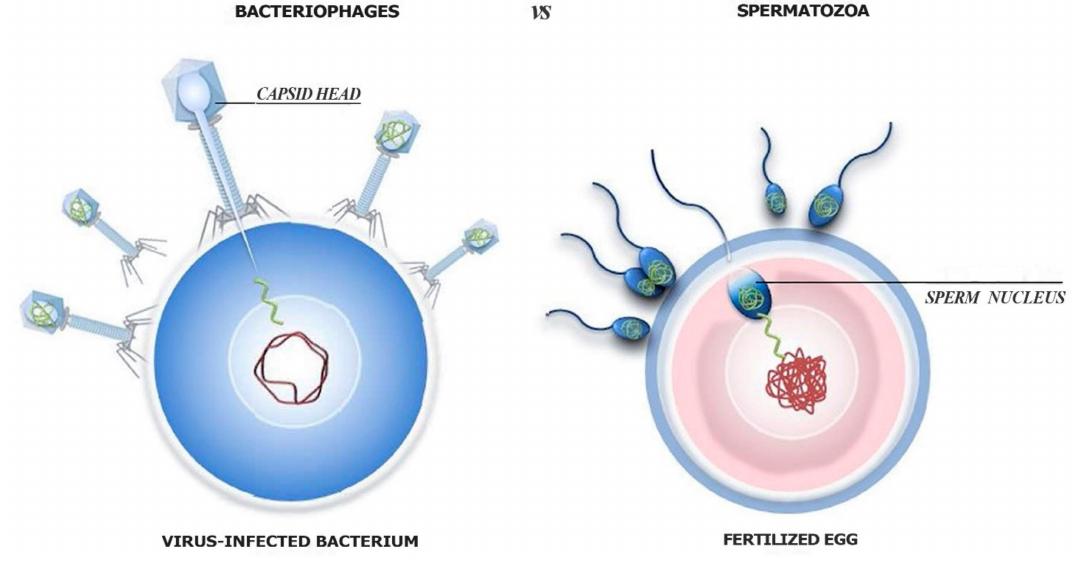
Figure 1. Virus–cell mating pairs: a primordial form of “sexuality”. Bacteriophages and male gametes have the ability to insert new genetic material (novelties) into prokaryotic cells and oocytes, respectively. (For reference, see the